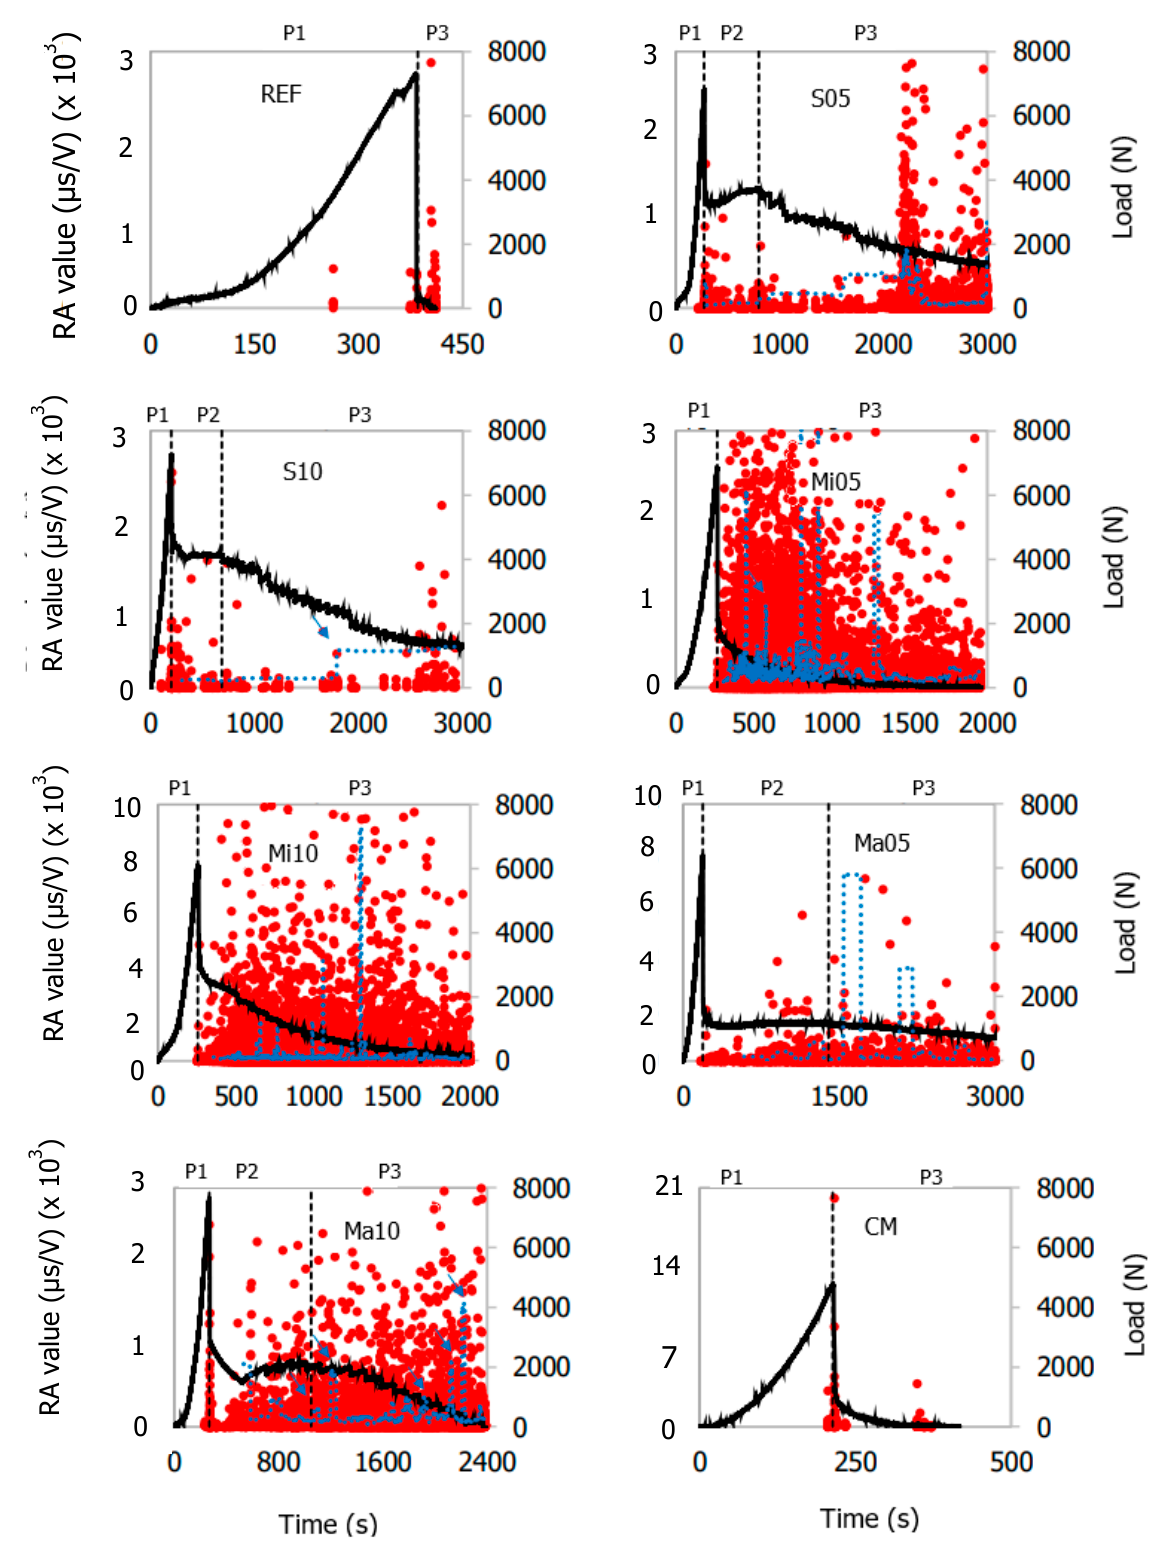
Figure 12. Corrected RA value distributions of the AE activities ( ● Corrected RA value, ● ● ● Moving average of corrected RA value, ― Load).